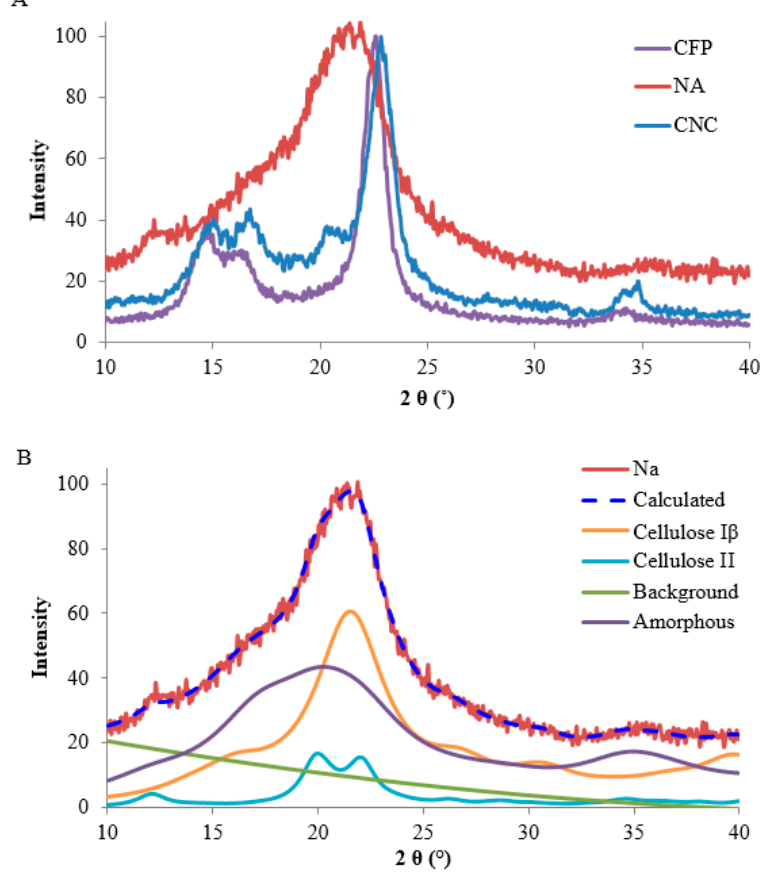
Figure 2. X-ray observed diffraction patterns ( A ) of the CFP, NA, and NC transducers; and ( B ) the calculated pattern of the NA as analyzed using the Rietveld method.